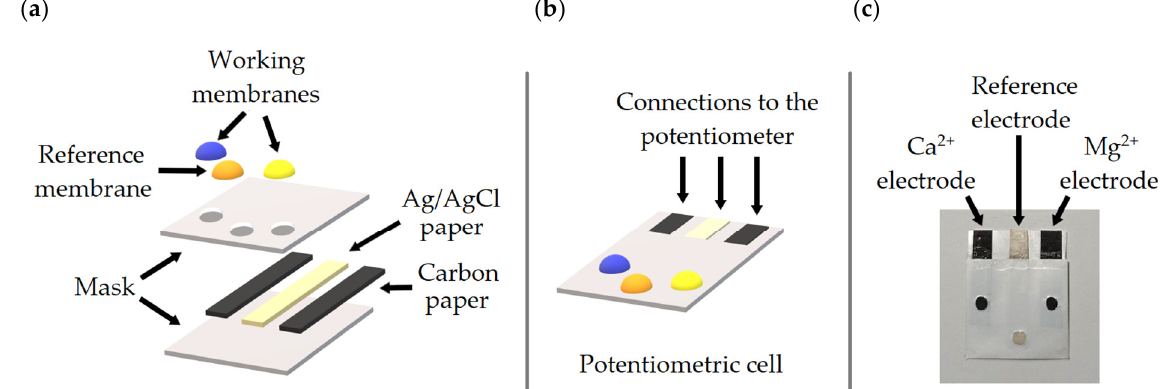
Figure 1. Paper-based potentiometric cell with two working electrodes and a reference electrode: ( a ) potentiometric cell construction, ( b ) scheme of the complete potentiometric cell, and ( c ) picture of the as-built paper-based cell.